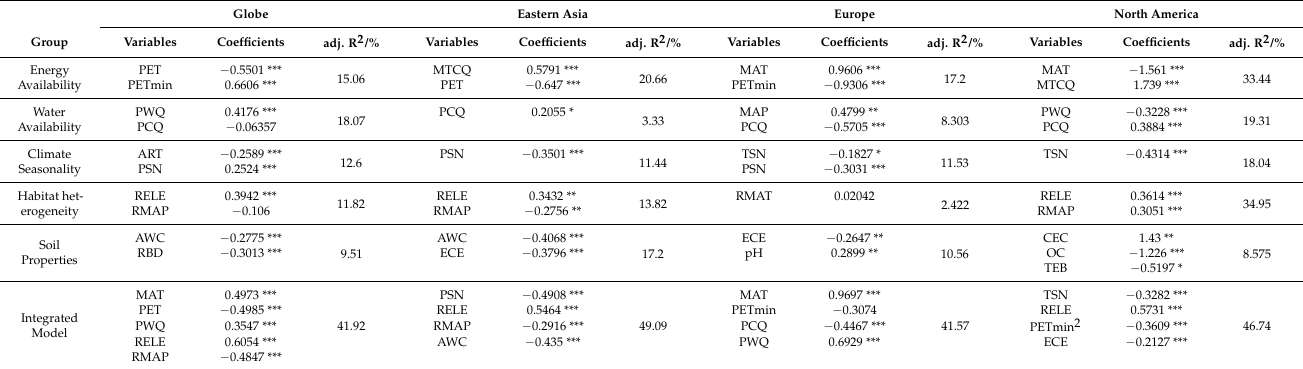
Table 3. Stepwise regression models for each group of variables and the integrated model for the globe and three